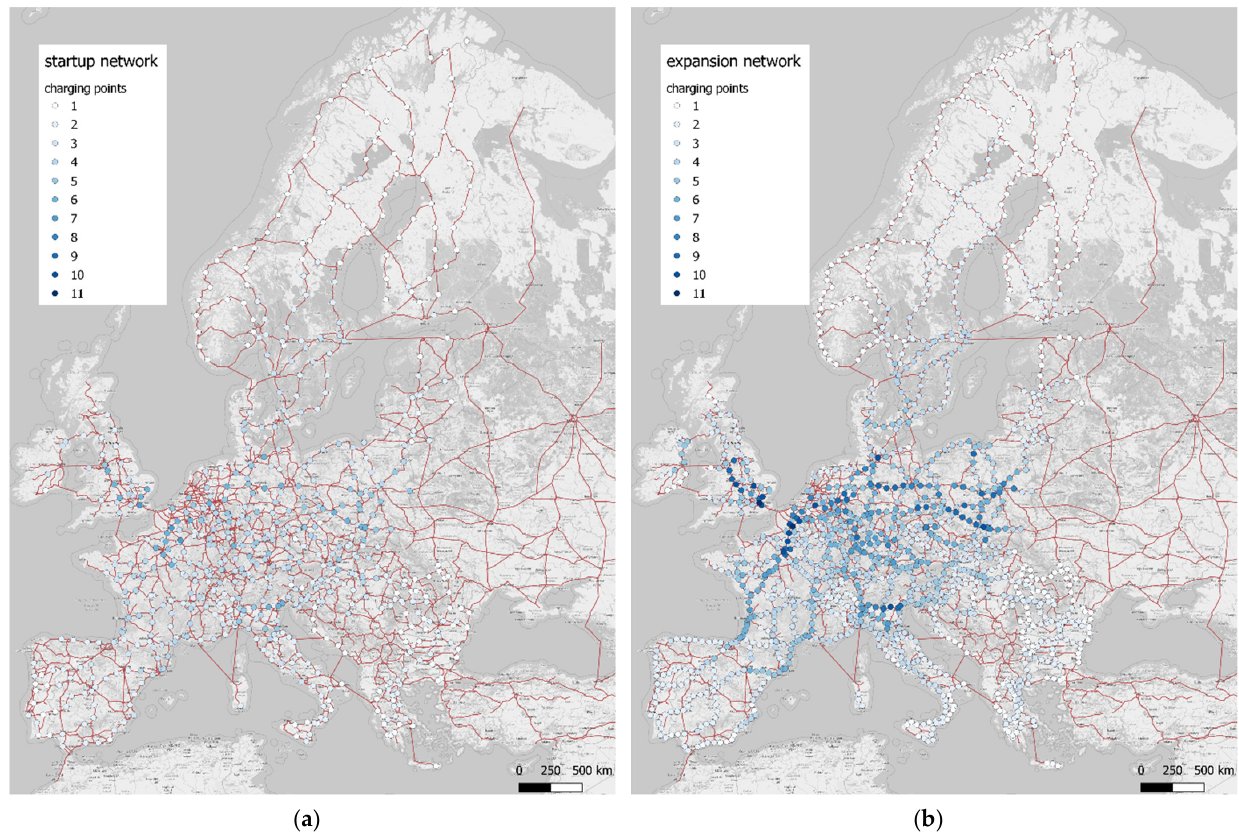
Figure 3. Location of 660 charging locations in the startup network ( a ) and 1468 charging locations in the expansion network ( b ). Background: OpenStreetMap.